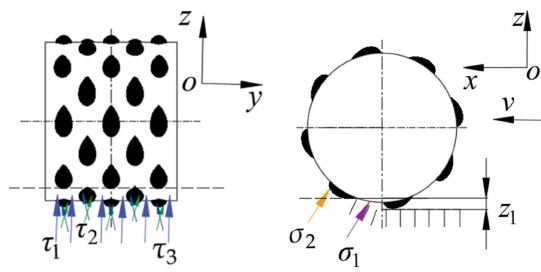
Figure 9. Sketch of forces on non-smooth press